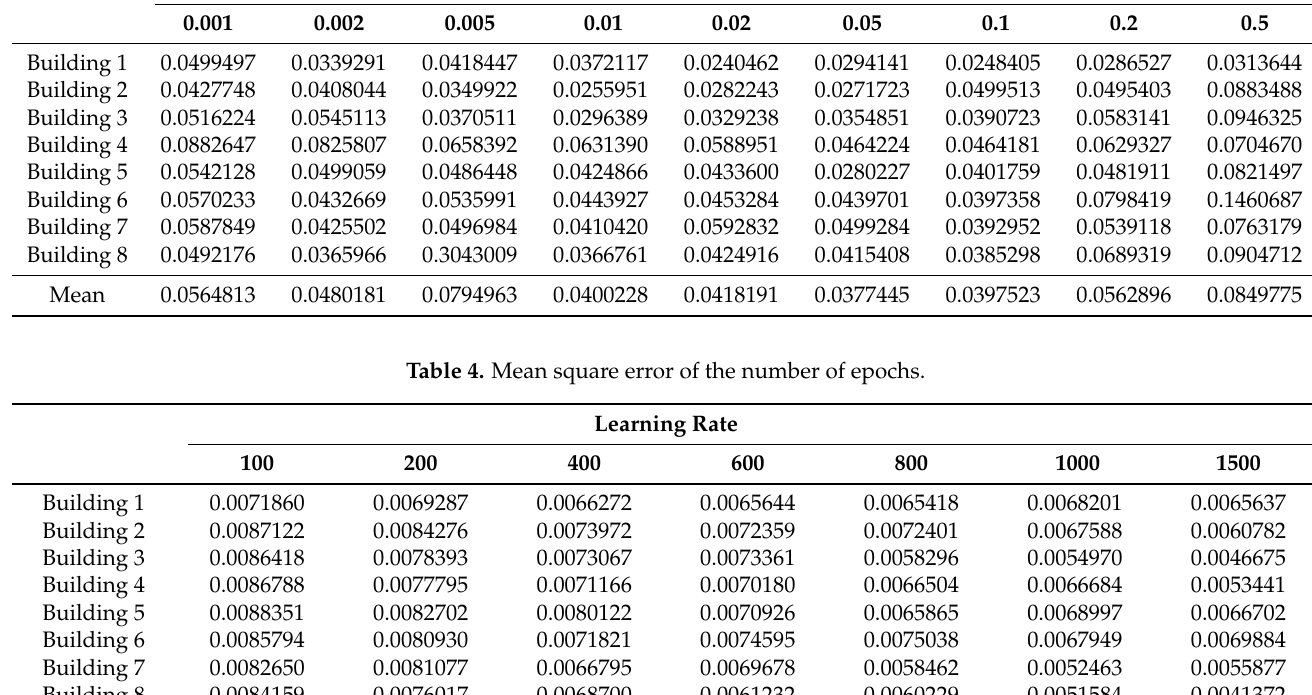
Table 3. Mean square error of the learning rate parameter. Learning Rate